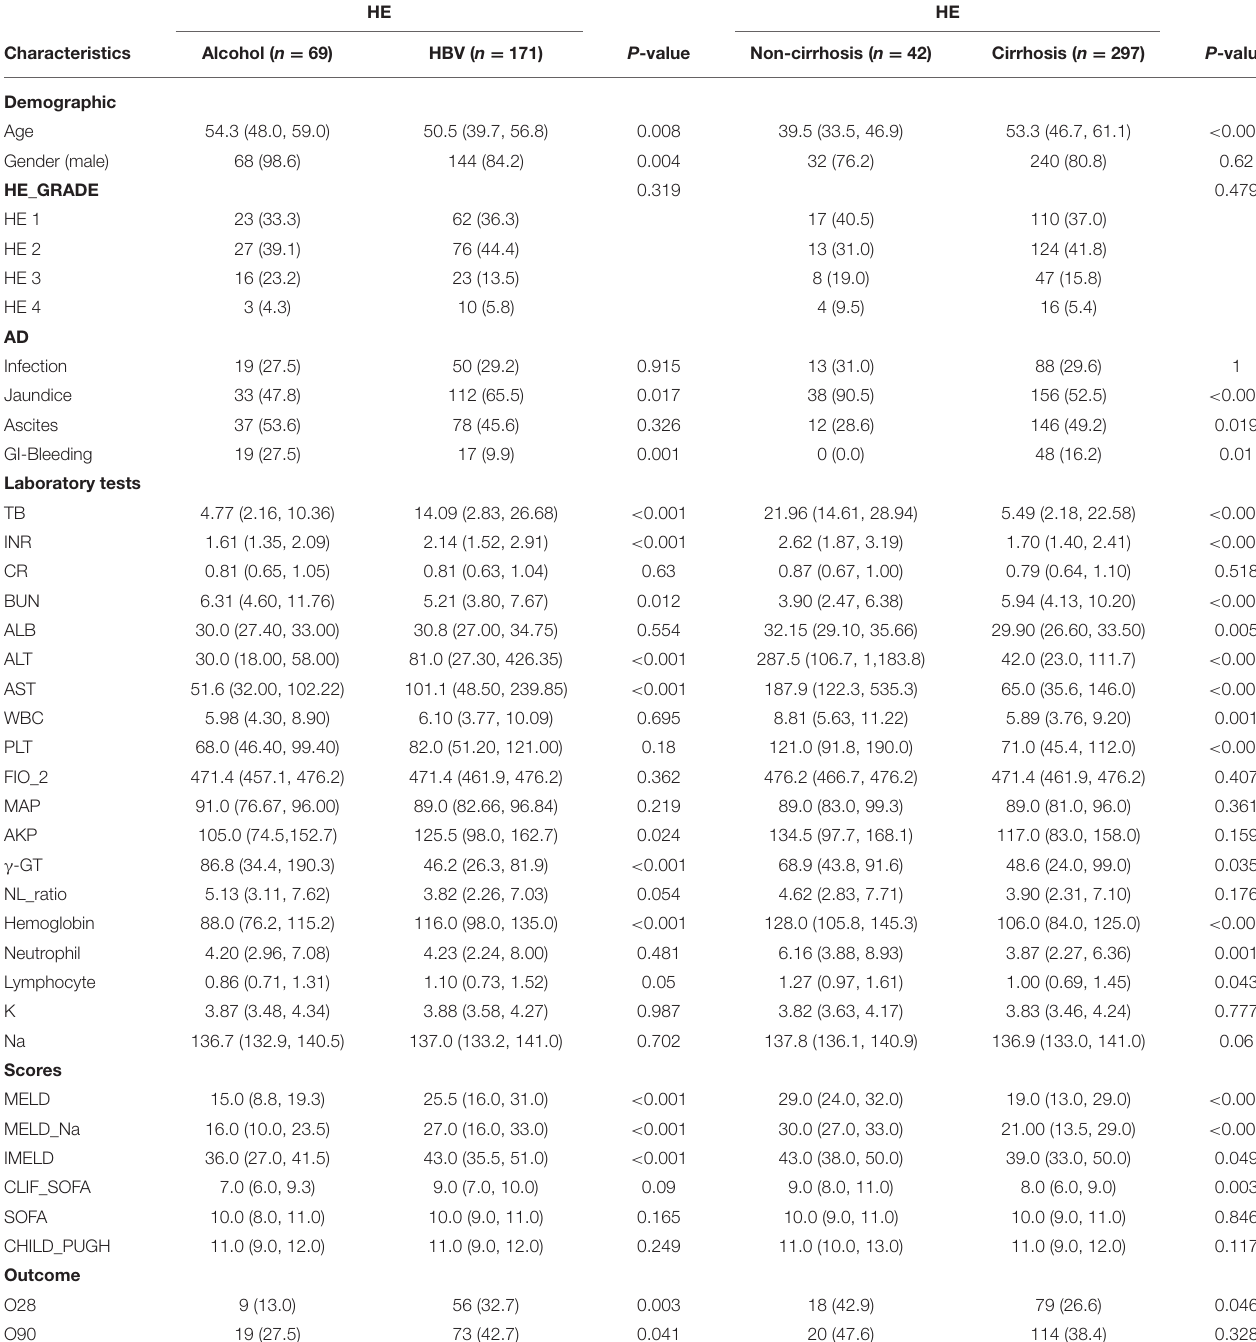
TABLE 3 | Characteristics of HE patients with different